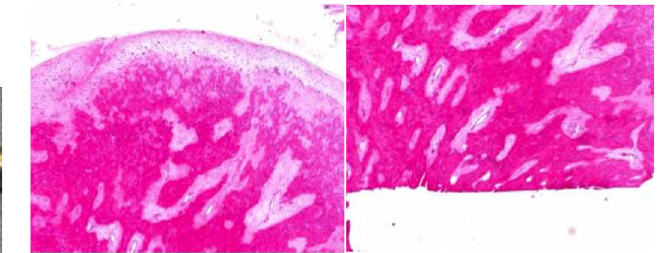
Fig. 4. Views of the upper part of the lesion as well as the deep part. It is a lesion of the bone nature, consisting of a fairly dense fi brous bone, persisted spaces occupied by a highly collagenized tissue, this bone tissue has many resorption stalls. The deep part goes into the lesion